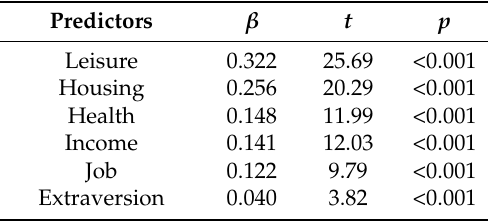
Table 6. Standardized regression coefficient ( β ), t -value, and p -value for predictors of overall satisfaction score for Survey 2. Personality measured with